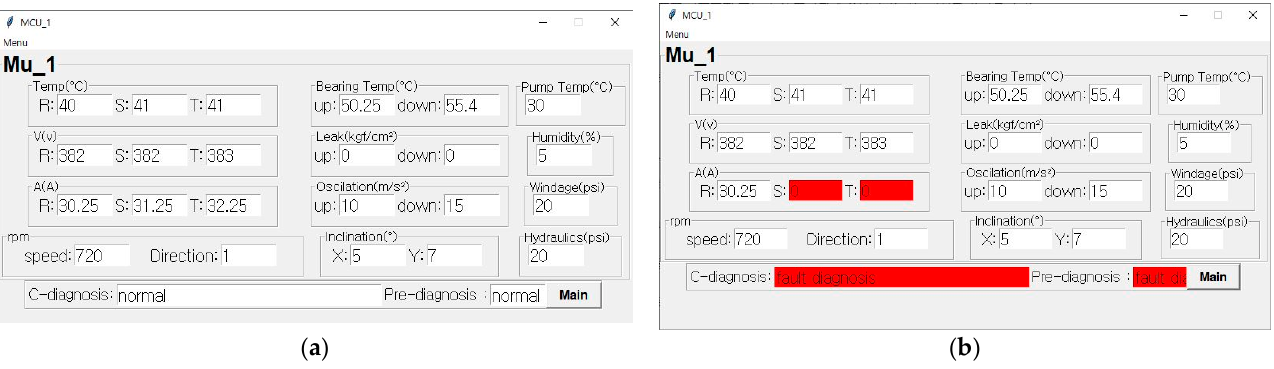
Figure 10. Monitoring status of ESP: ( a ) Normal operation monitoring; ( b ) Fault operation monitoring.